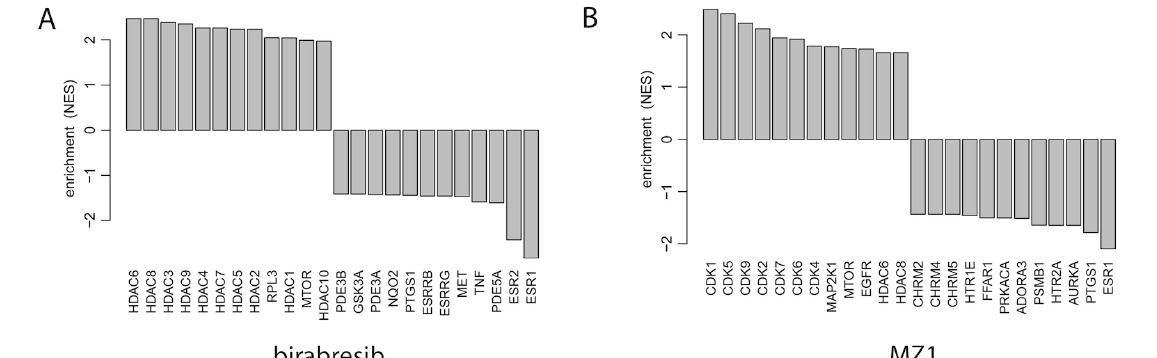
Figure 5. Drug connectivity enrichment plots showing the top pharmacological targets having similar or opposite enrichment in birabresib (left panel) or MZ1 (right panel) signatures obtained in two ABC DLBCL cell lines exposed to the two compounds or to DMSO, as control. RPL3: ribosomal protein L3; PDE3B: phosphodiesterase 3B; GSK3A: glycogen synthase kinase 3 alpha; NQO2: N -ribosyldihydronicotinamide:quinone reductase 2; PTGS1: prostaglandin-endoperoxide synthase 1; ESRRB: estrogen related receptor beta; ESRRG: estrogen related receptor gamma; MET: MET proto-oncogene, receptor tyrosine kinase; TNF: tumor necrosis factor; PDE5A: phosphodiesterase 5A; ESR2: estrogen receptor 2; MAP2K1: mitogen-activated protein kinase kinase 1; EGFR: epidermal growth factor receptor; CHRM2: cholinergic receptor muscarinic 2; HTR1E: 5-hydroxytryptamine receptor 1E; FFAR1: free fatty acid receptor 1; PRKACA: protein kinase CAMP-activated catalytic subunit alpha; ADORA3: adenosine A3 receptor; PSMB1: proteasome 20S subunit beta 1; HTR2A: 5-hydroxytryptamine receptor 2A; AURKA: aurora kinase